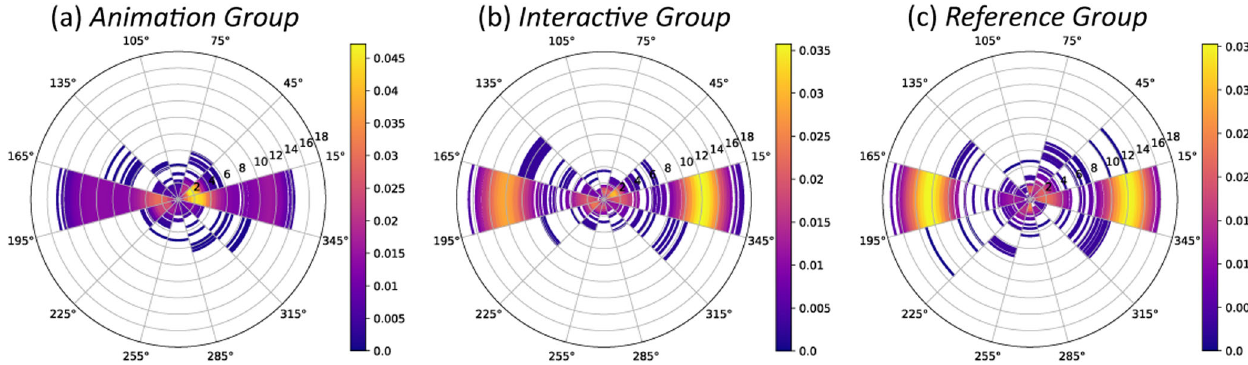
8. The diagrams show the lengths and angular distributions of saccades during training task 1 in the animation group (a), interactive group (b), and reference group (c). Saccades were grouped into angular fields depending on their direction. The saccadic length in centimeters is encoded in the radial distance to the origin. The probability density of the saccades is color